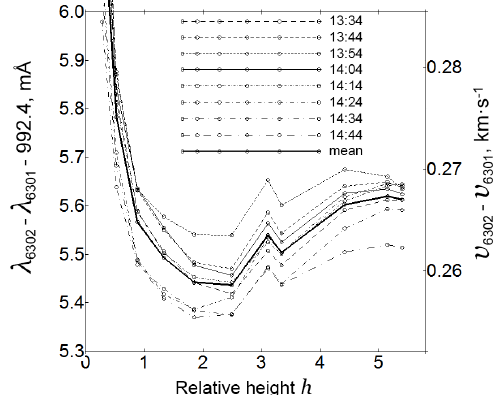
Figure 8. The differences of averaged over the whole map 6302 and 6301 COG velocities for 8 maps. The standard error for each map is Figure 9.